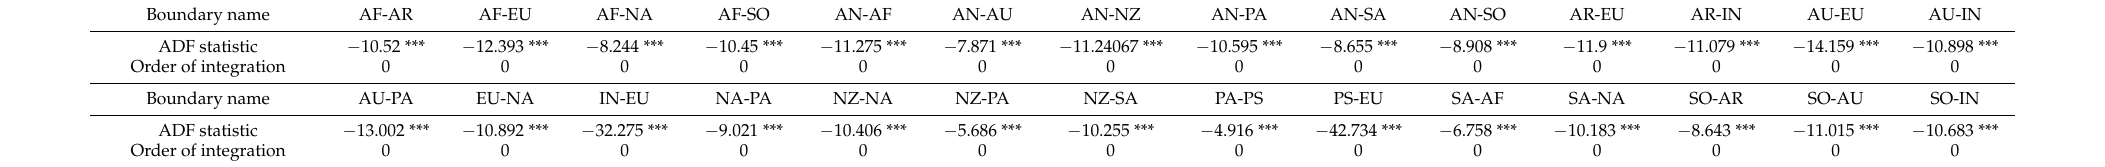
Table 2. Unit root test using ADF for annual energy release at plate